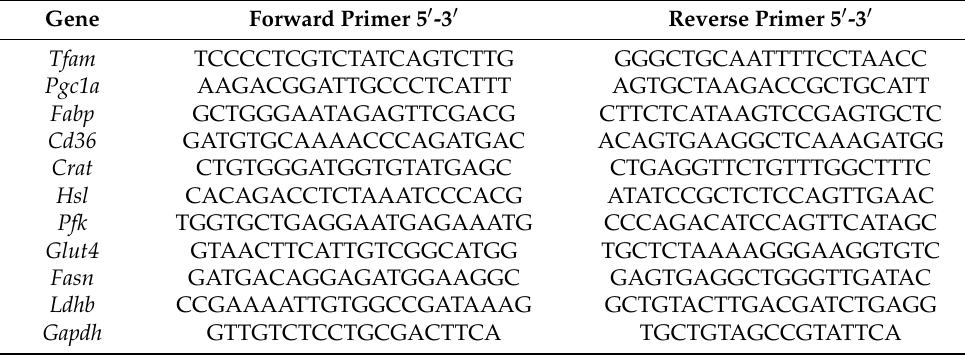
Table 1. Primers used for PCR.